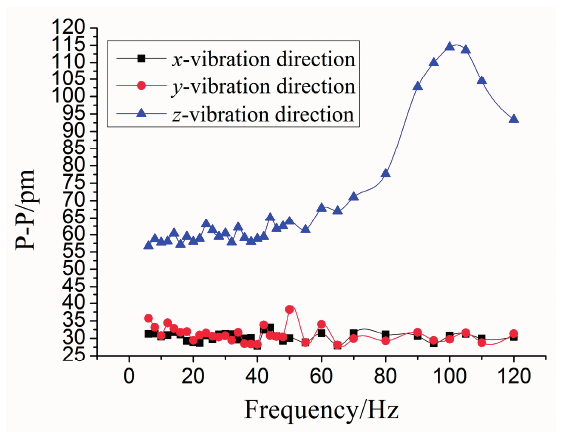
Figure 14. Amplitude-frequency curves of each direction under z -direction excitation.